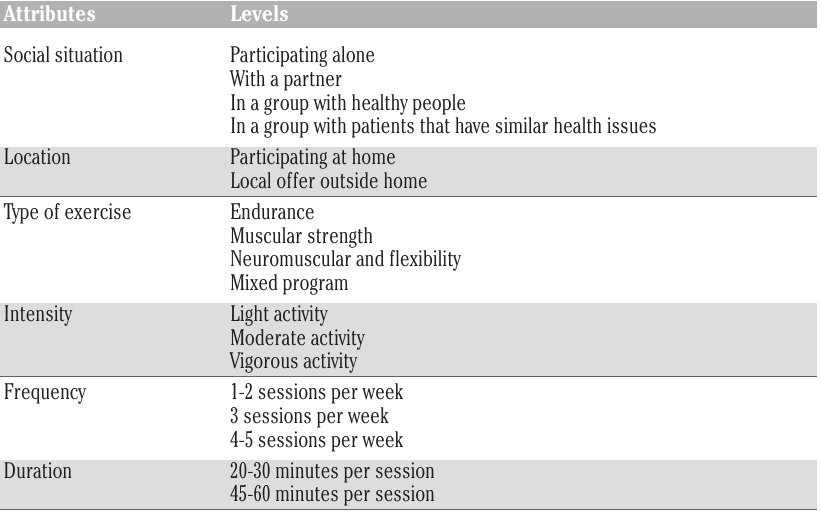
Table 1. Attributes and levels of the discrete choice